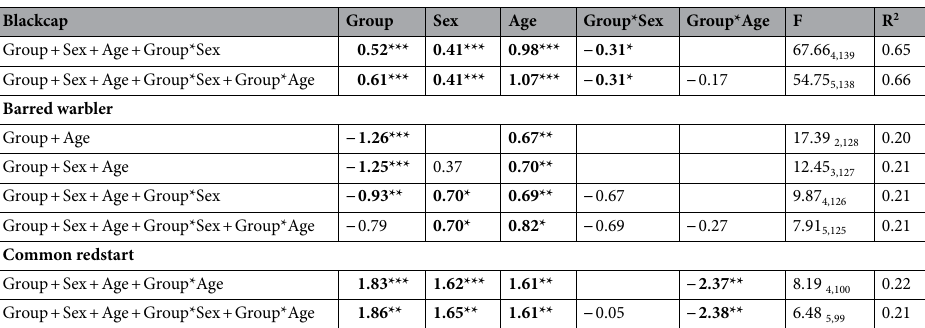
Table 1. Models comparing the wing length of early and late arrivals. Model selection table and slopes for each variable in the linear models comparing the wing length of individuals from the early (first 30%) and late (last 30%) arrival groups (“Group”), with Sex and Age (second year or adults) as response variables. F-Statistic is presented for each model with degrees of freedom as subscripts. Post hoc tests were performed on models with significant interaction (Table